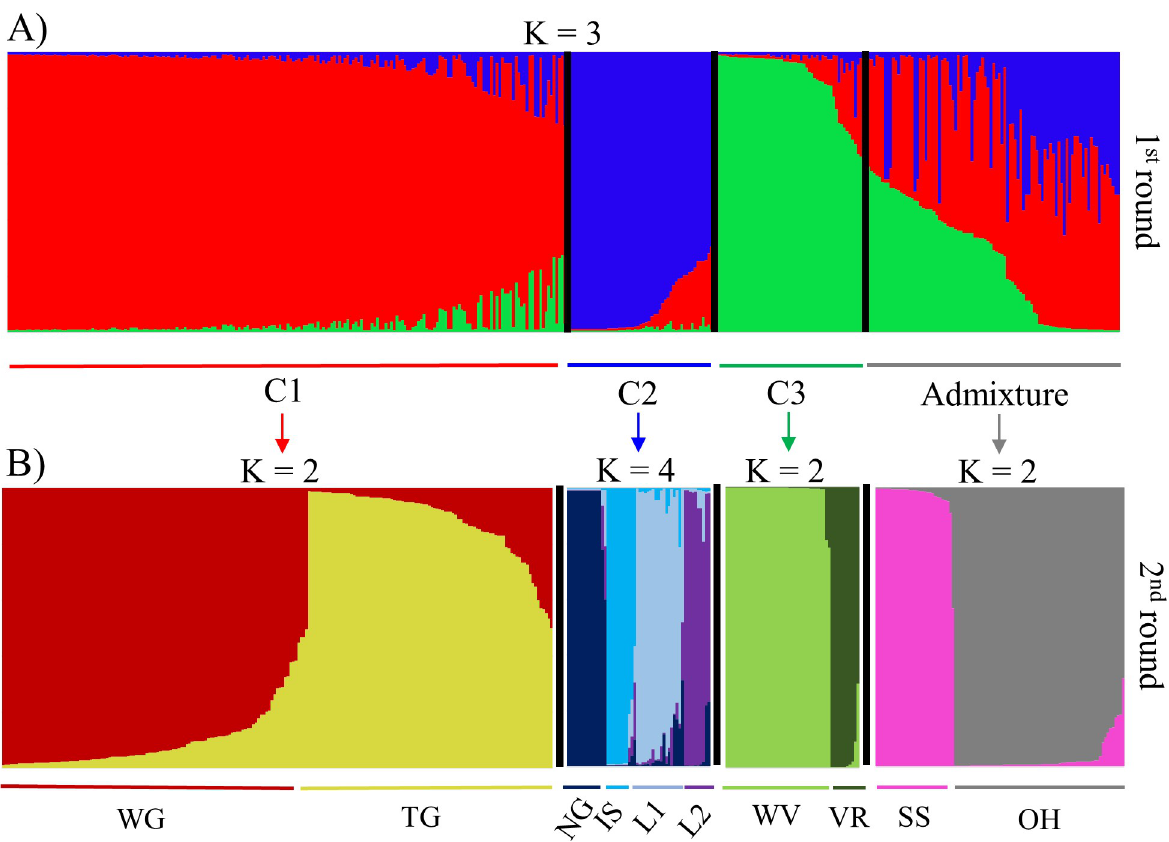
Fig 2. Genetic structure of the Vitis germplasm accessions obtained on the basis of 17 microsatellite markers. Bar graphs of the estimated membership proportions (q) for each of the 410 accessions. Each accession is represented by a single vertical line, which is partitioned into colored segments in proportion to the estimated membership in each cluster. (A) First round of STRUCTURE analysis, inferred genetic structure for K = 3. Cluster 1 (C1): genetic predominance of the species V . vinifera ; cluster 2 (C2): genetic predominance of the species V . labrusca ; cluster 3 (C3): genetic predominance of wild Vitis species; Admixture: interspecific hybrids with a membership of q < 0.70. (B) Second round of STRUCTURE analysis. WG: wine grape accessions related to V . vinifera ; TG: table grape accessions related to V . vinifera ; NG: ‘Niagara’ accessions; IS: ‘Ives’ and ‘Isabella’ accessions; L1 and L2: Others V . labrusca hybrids; WV: accessions related to wild Vitis species; VR: V . rotundifolia accessions; SS: accessions related to the Seibel series; OH: complex interspecific